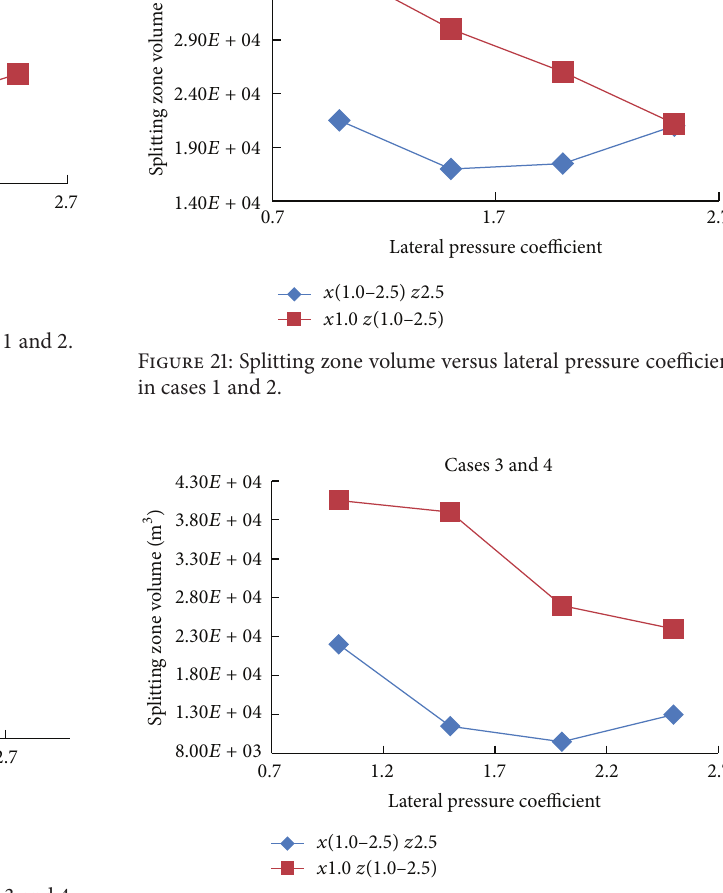
Figure 22: Splitting zone volume versus lateral pressure coefficient in cases 3 and 4